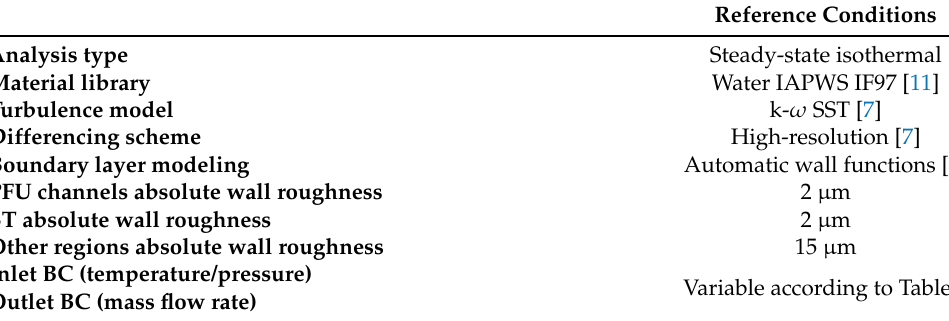
Table 3. Summary of OVT mock-up CFD analysis